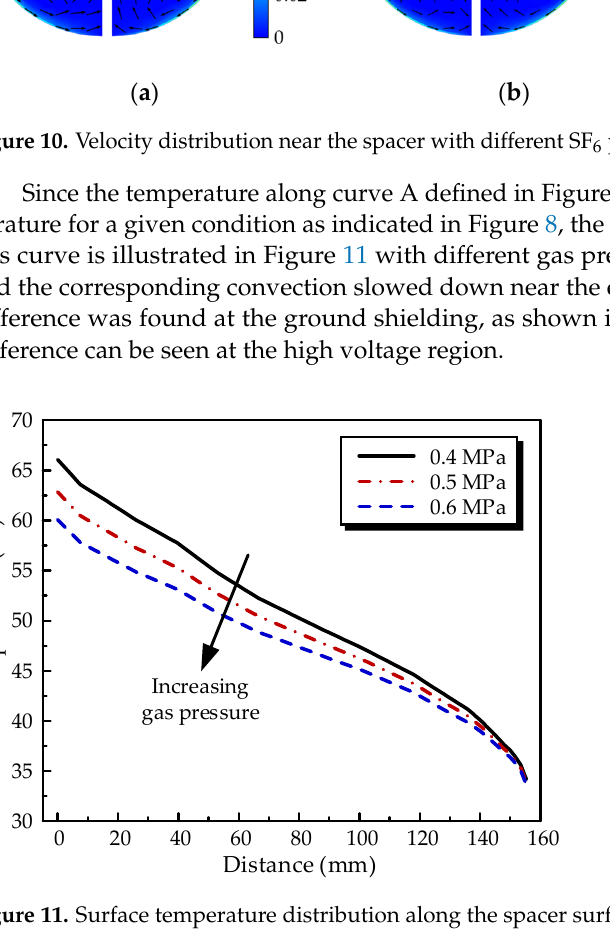
Figure 10. Velocity distribution near the spacer with different SF 6 pressures. ( a ) 0.4 MPa, ( b ) 0.6 MPa.